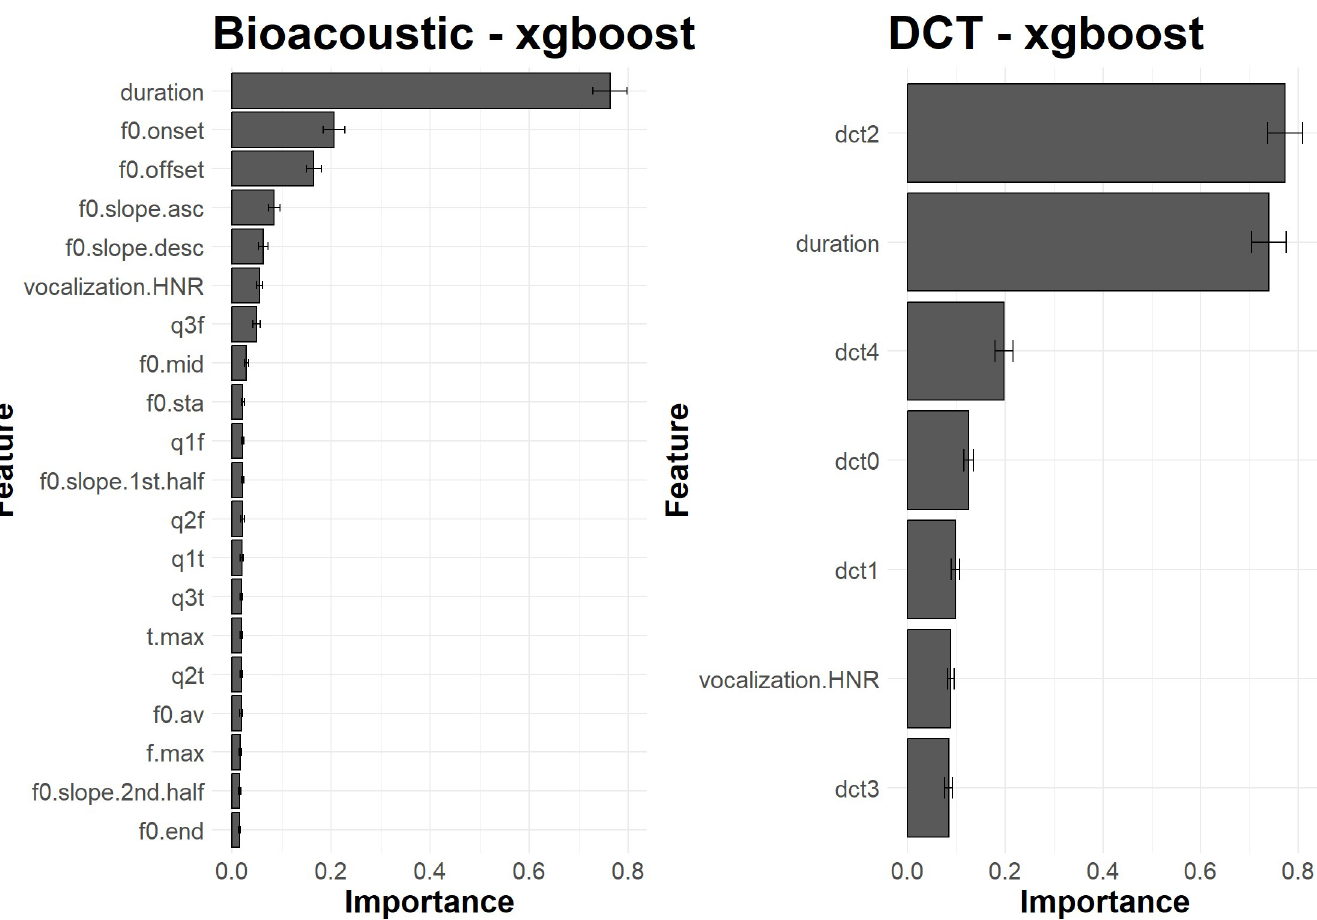
Fig 8. Average importance of acoustic features, for 100 iterations of the evaluation process, when classifying call types with xgboost. Left . Features of the Bioacoustic set. Right . Features of the DCT set. The bar plots illustrate the relative influence of each acoustic feature on the classification performance. The error bars report the standard deviation of the measure of importance for the 100 iterations of the evaluation